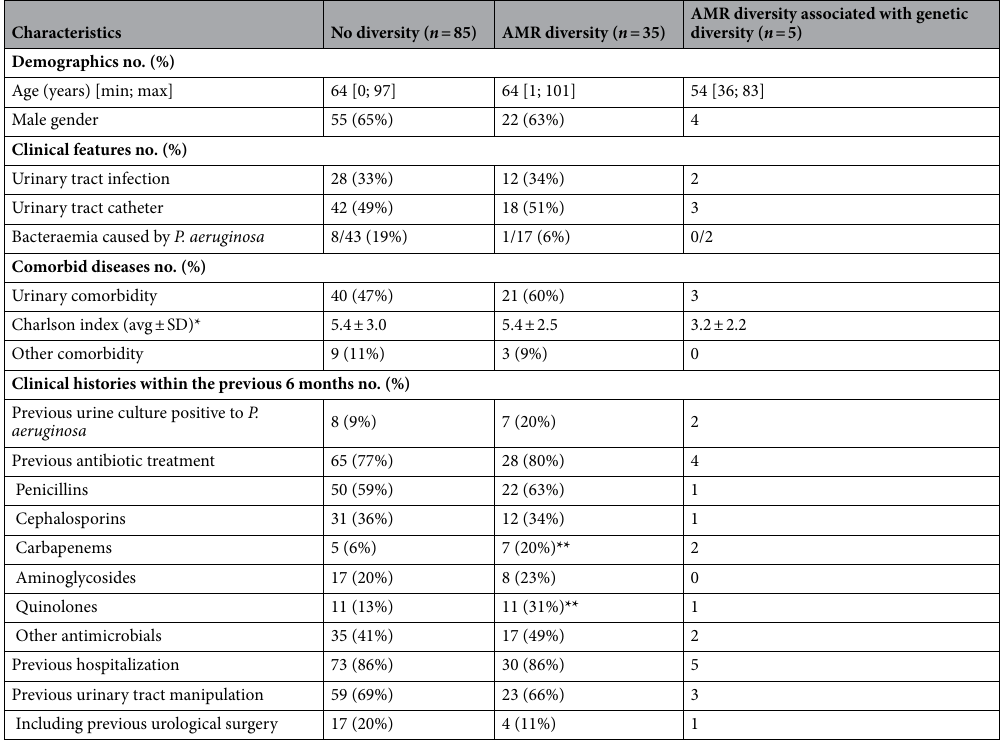
Table 1. Clinical characteristics of patients with phenotypic and molecular within-host diversity. MDR multidrug resistant, XDR extensively drug resistant, AMR antimicrobial resistance, min minimum, max maximum, SD standard deviation. *Charslon index was measured only for adult cases (i.e. 114 patients, 37 with UTI, and 77 with AB). ** P value < 0.05.